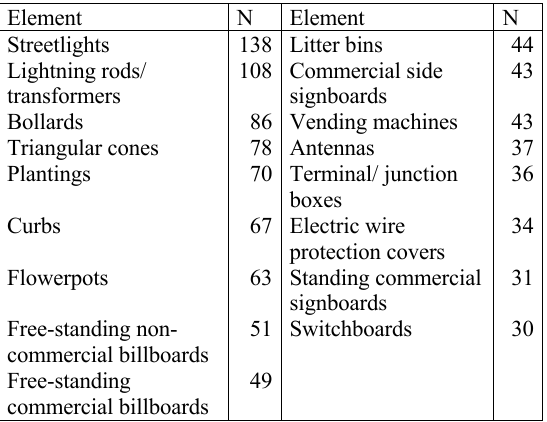
Table 5 . List of frequently appearing elements in “void” regions.